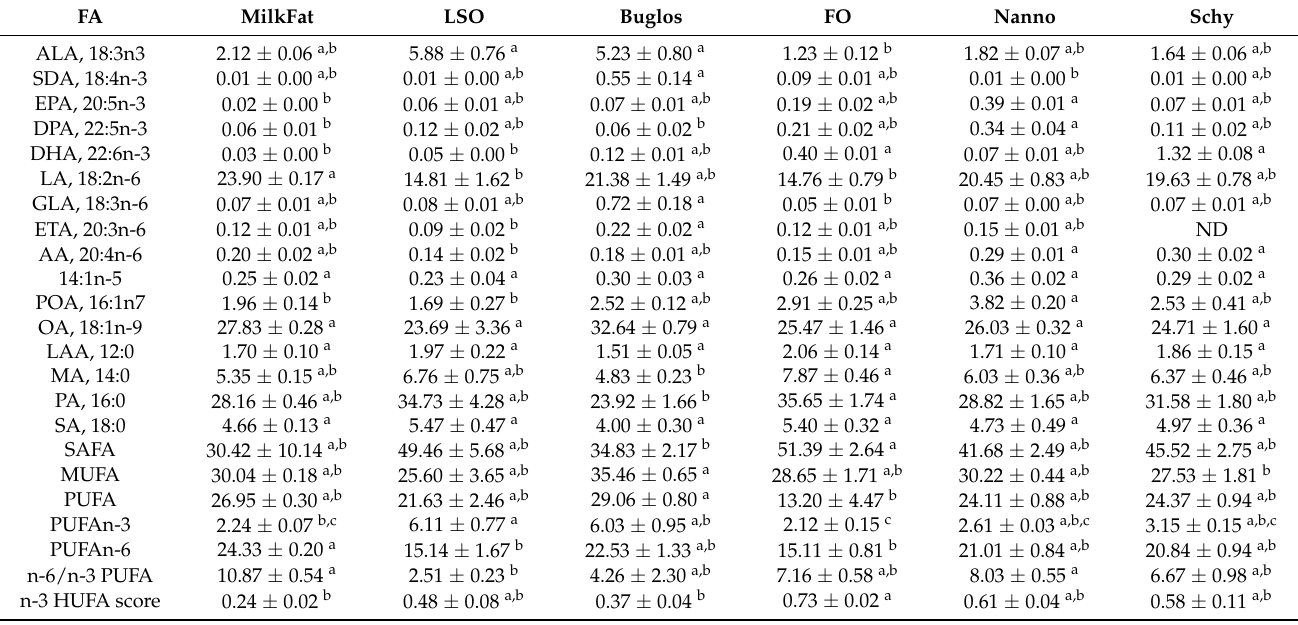
Table 5. Changes of fatty acid (FA) profile in visceral adipose tissue (VAT) of Wistar rats fed with different